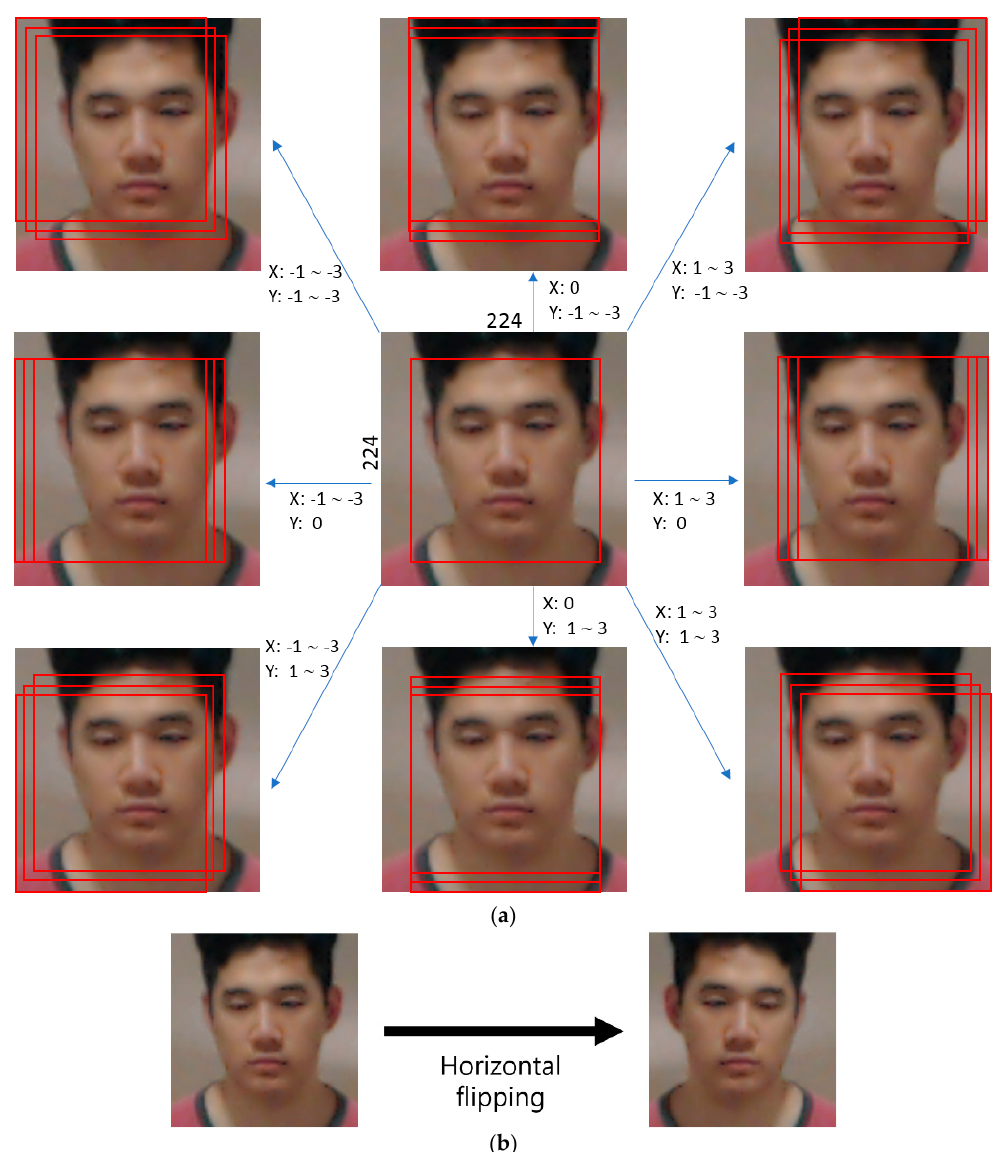
Figure 12. Data augmentation method by ( a ) image translation and cropping, and ( b ) horizontal flipping. Using the augmented data, fine-tuning was performed on pre-trained VGG Face-16 and ResNet-50 models using the SGD method. As explained in Section 4.5, unlike the GD method, in the SGD method, the number of training sets divided by mini-batch size is defined as an iteration, and one epoch is set when training is performed for all the iterations. In this study, the momentum, weight decay, and learning rate during training were set at 0.9, 5 × 10 − 4 , and 1 × 10 − 5 , respectively, and the batch size was 20. Training with DFB-DB1 was performed for 20 epochs, and training with the ChokePoint database was performed for 15 epochs. Because the number of images in the ChokePoint